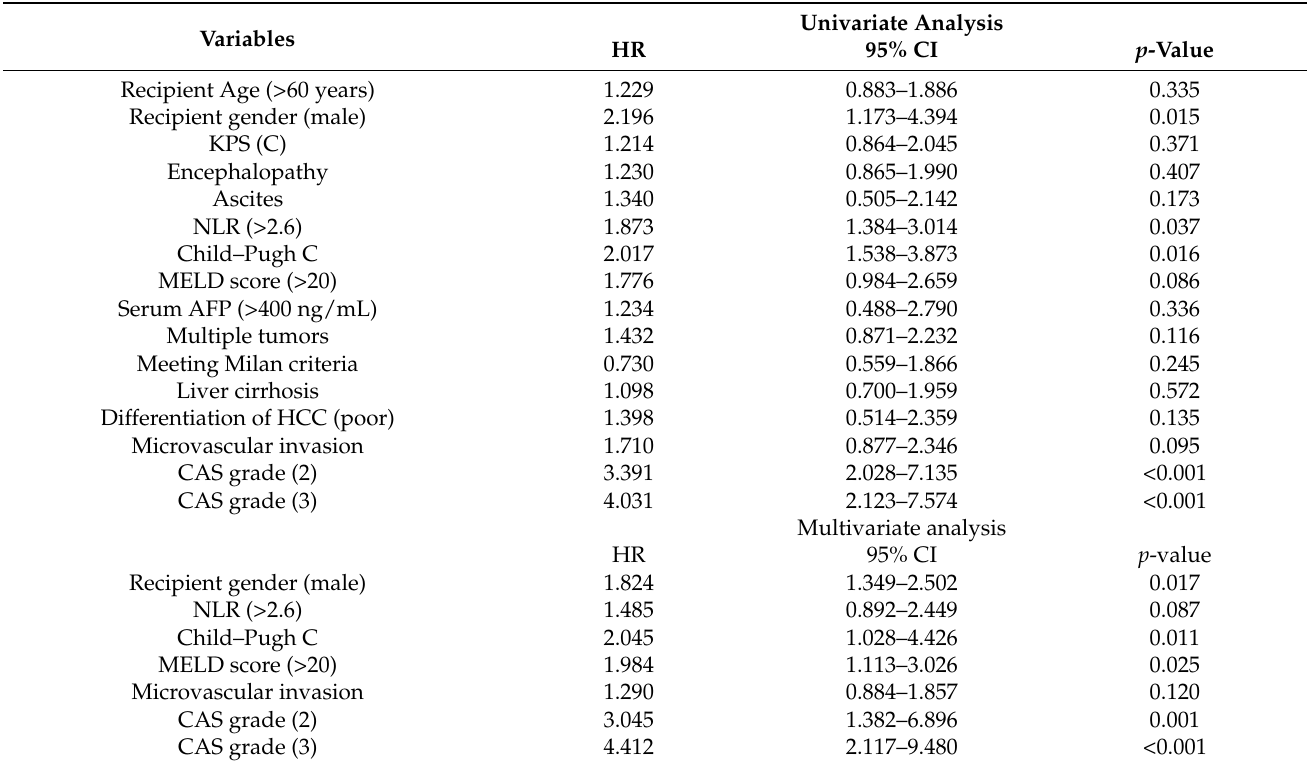
Table 4. Univariate and multivariate analysis identify independent prognostic factors for overall survival in the